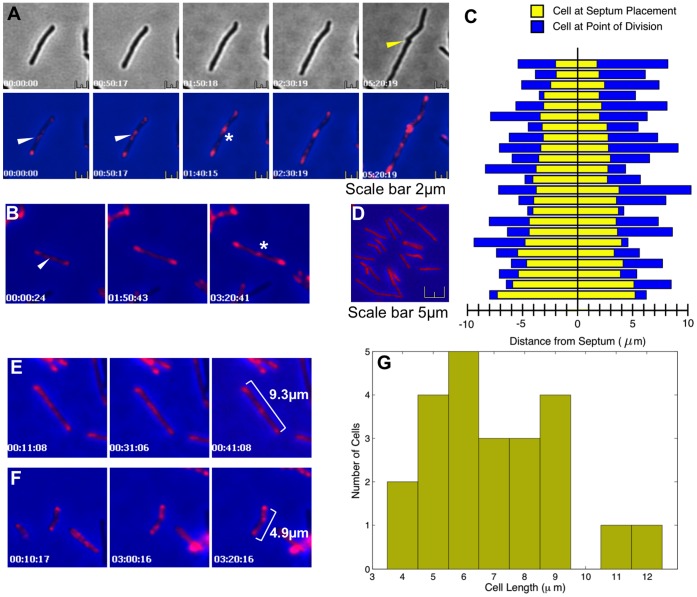
PBP1a-mCherry localizes centrally at septa that form future cell division sites, independently of cell length.PBP1a-mCherry expression in M. smegmatis mc2155 was induced with 20 ng/ml Tc for 3.5 hr cells and images were captured every 10 mins as described. Panels A and B are time series of images showing diffuse patches of staining at variable locations between the poles (white arrow). These eventually condensed into a central septal spot (white asterisk) around mid-cell. Cell envelope invagination and separation was not seen in the bright field images until 160 minutes after this condensation event (n = 10; yellow arrow). See File S1 and File S2 for complete movie sequences. The septal spots of PBP1a-mCherry form within the central 20% of the cell (Panel C; n = 23), without the outliers seen with Vancomycin staining. Panel D shows a control strain expressing mCherry alone. Septal spots are present in cells of various lengths (panels E and F), ranging between 4 and 12 µm (G), showing that cell division occurs at a wide range of cell lengths, indicating it is not a cue for placement of the new septum. See File S3 and File S4 for complete movie sequences.